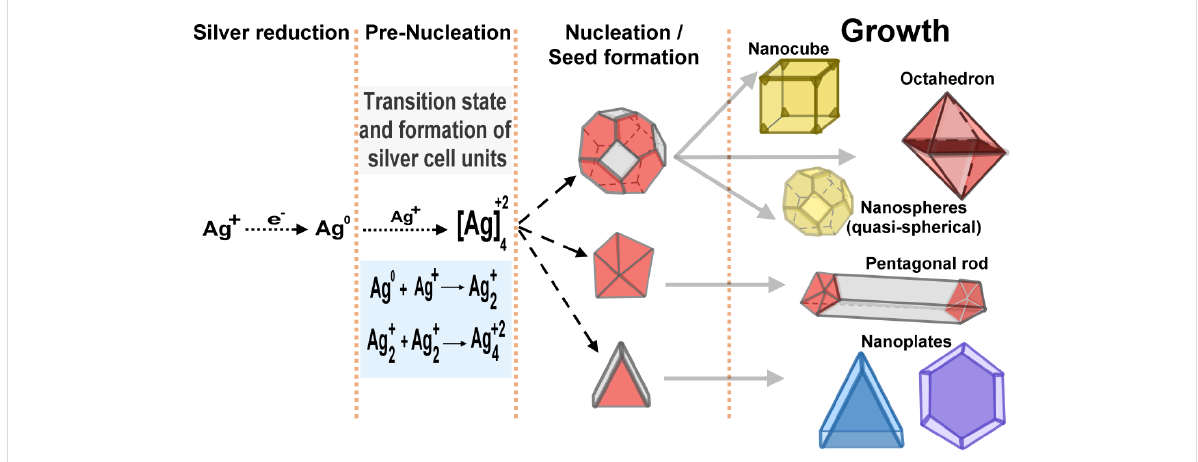
Figure 10: Schematic illustrating the reduction of silver ions, pre-nucleation, nucleation and growth steps in the formation of AgNPs with different shapes (e.g., nanocubes, octahedron, nanospheres, nanorods, and nanoplates) via the polyol synthesis process.